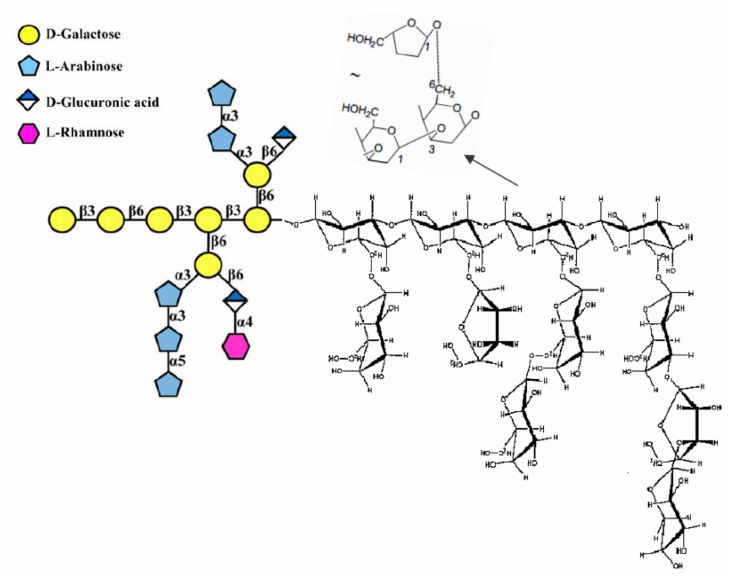
Figure 2. Schematic structure of fragment of